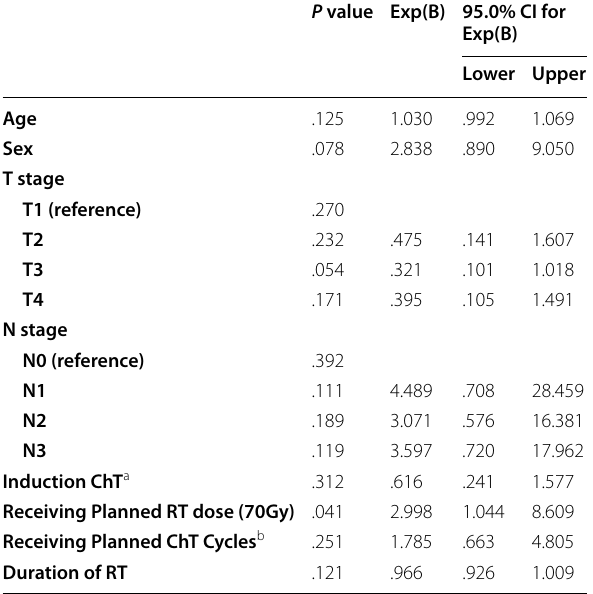
Table 2 Predictors of progression free